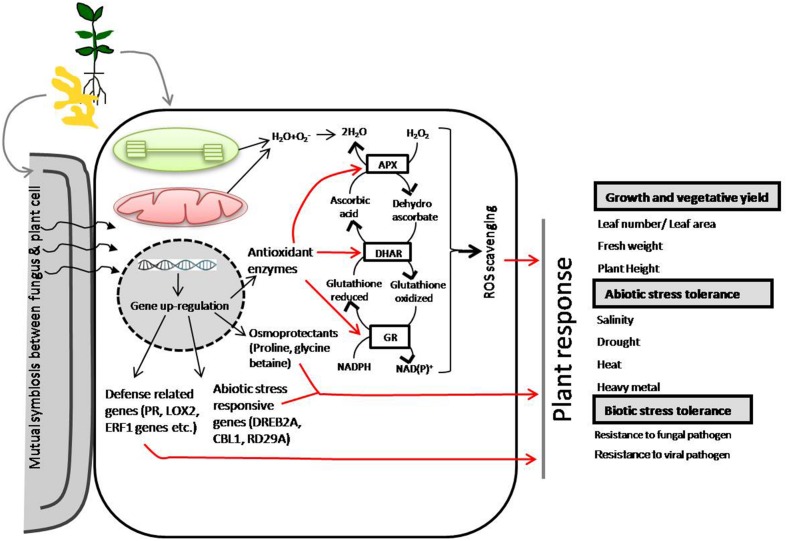
Schematic representation of Piriformospora indica symbiotic association-mediated crop/plant abiotic and biotic stress tolerance (Camehl and Oelmüller, 2010; Sun et al., 2010; White and Torres, 2010; Foyer and Shigeoka, 2011; Molitor et al., 2011; Hamilton et al., 2012; Zarea et al., 2012).